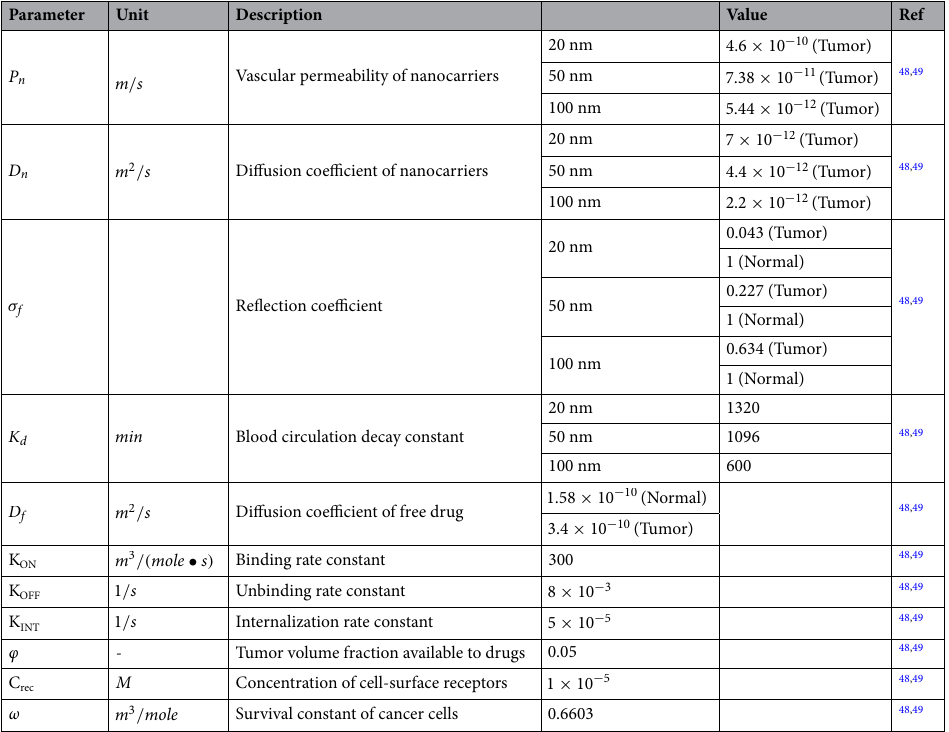
Table 3. Parameters for nanocarriers and doxorubicin